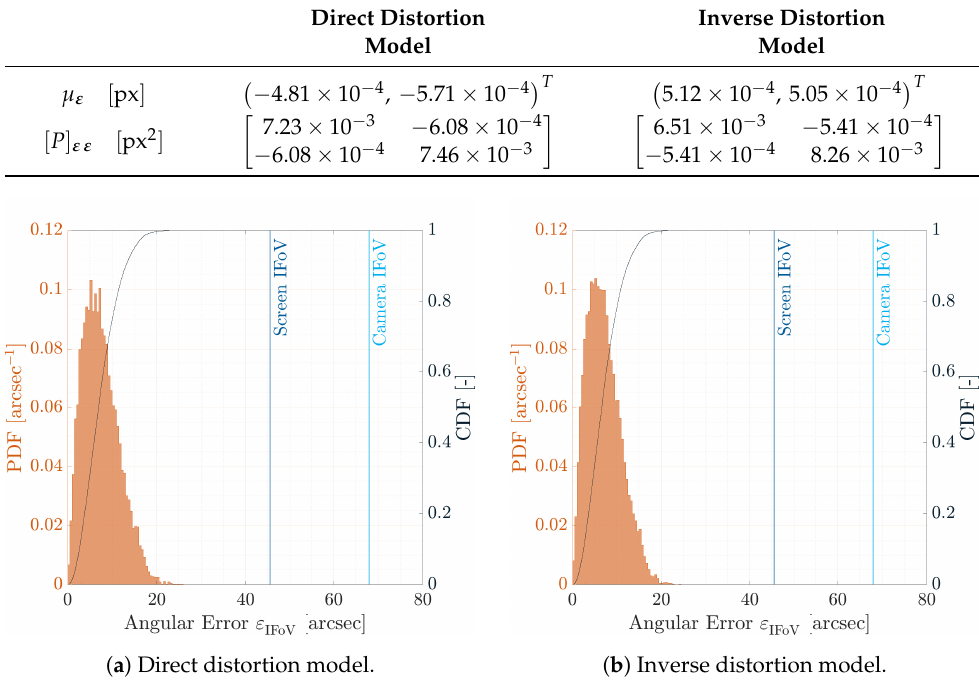
Figure 14. PDF and CDF of the error norm ε The vertical lines represent the facility iFoV θ f